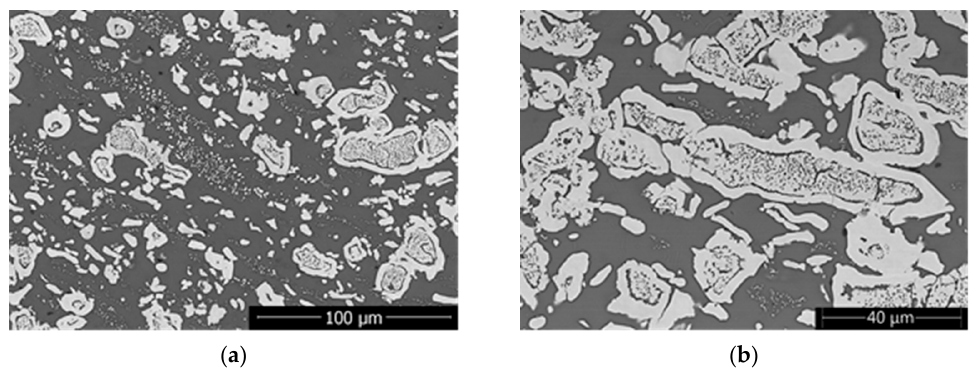
Figure 12. ( a ) Low magnification and ( b ) higher magnification BSE images of Re 0.3 TaTiZr alloy sample after compression deformation at 1000 °C with a true strain of 0.69.